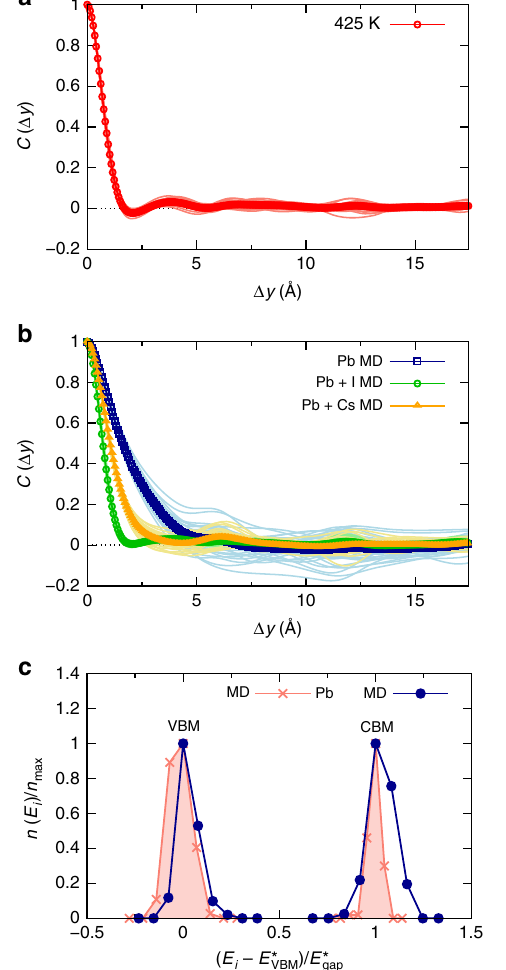
Fig. 6 Shortening of disorder potential and band-edge distributions in CsPbI 3 . a Autocorrelation function of the disorder potential, where the thin curves show sample snapshots taken along the MD trajectory, and the thick curves shows their average. The disorder potential in CsPbI 3 is also con fi ned to very short ranges. b Autocorrelation function of the disorder potential in CsPbI 3 corresponding to the three equivalent scenarios shown in Fig. 5a, where the thin curves show sample snapshots taken along the MD trajectory ( T = 425 K), and the thick curves their averages. Also in CsPbI 3 the correlation length in the disorder potential is dynamically shortened by the Cs and especially the I displacements. c Normalized histograms of the instantaneous VBM and CBM energies calculated equivalently to the data shown Fig. 5b. In CsPbI 3 the spread in the CBM energy distribution due to displaced Pb atoms is also reduced by the presence of the other displacements in the